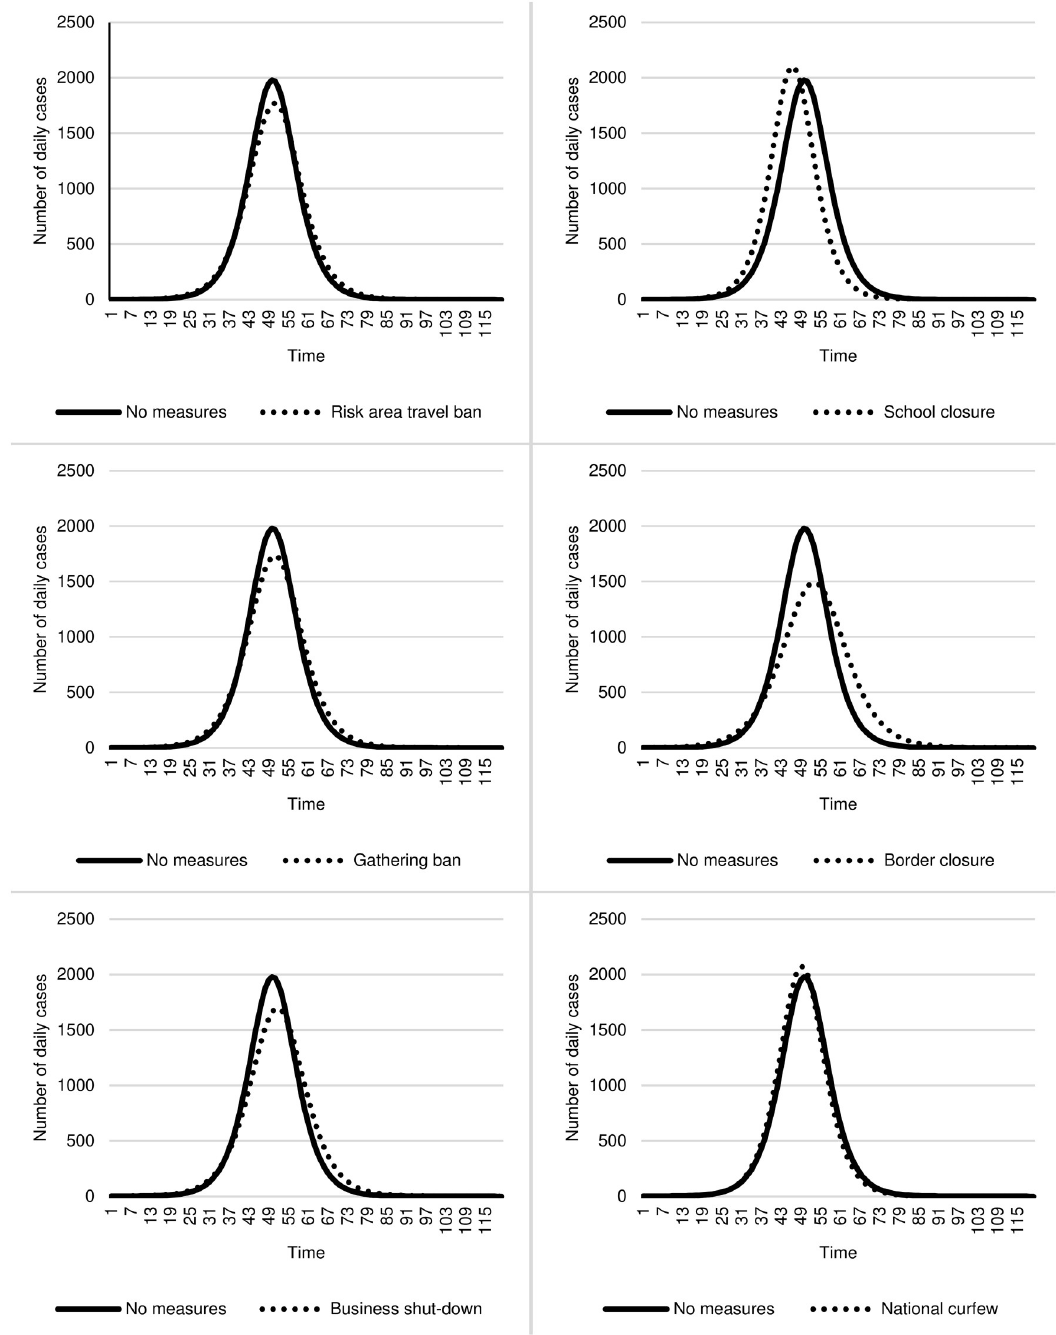
Fig 2. Flatten the curve—The effect of individual measures on the containment of the COVID-19 pandemic (incubation of 5 days).